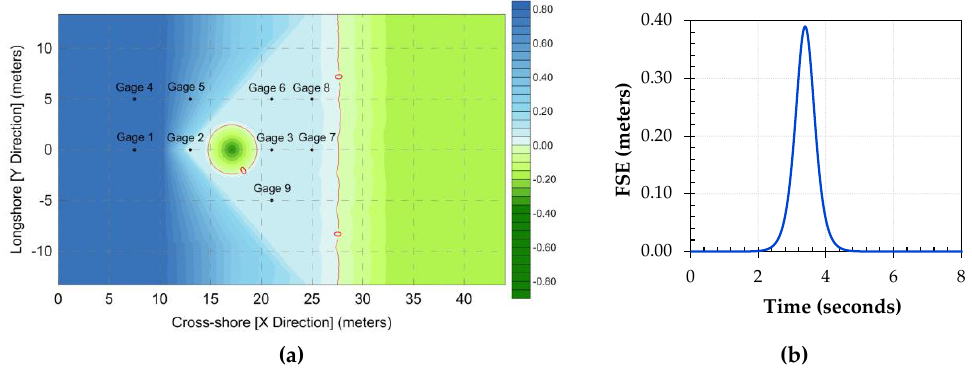
Figure 2. Model parameters: ( a ) bathymetry of the numerical model, NAMI DANCE; ( b ) incoming wave.